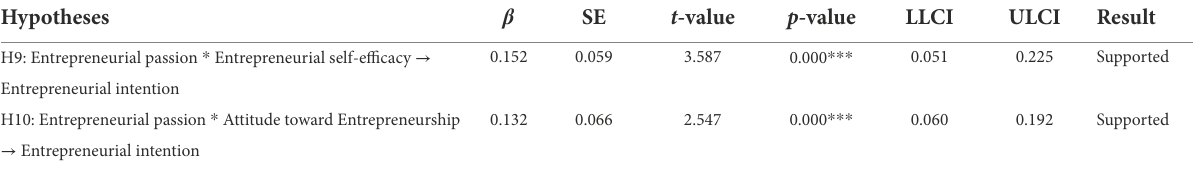
TABLE 6 Moderation tests (indirect